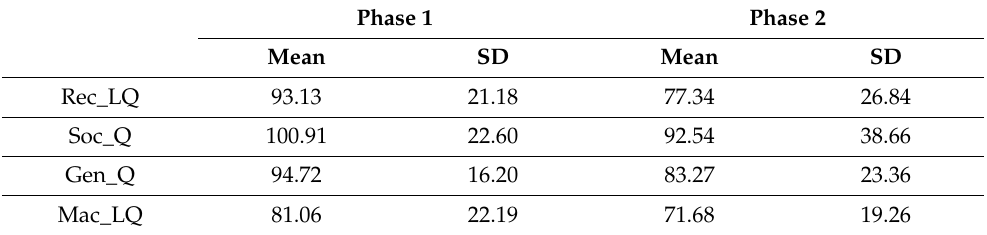
Table 4. Mean and SD of the developmental quotients at each test phase ( n =